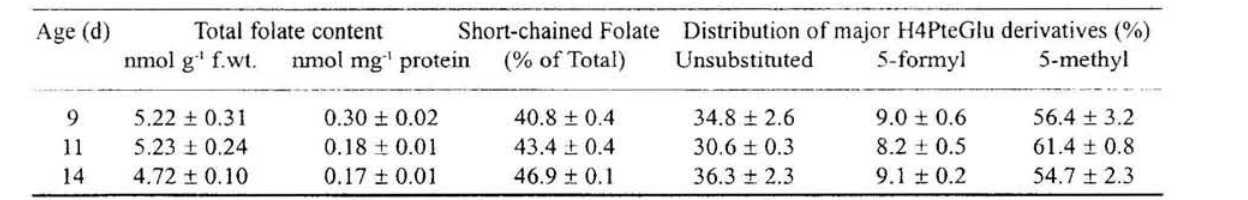
Table 1 The folate content of pea leaves. Pea leaves (excised from 9 to 14 day seedlings) were extracted and assayedfor total folate usingL. rhamnosus (see Materials and